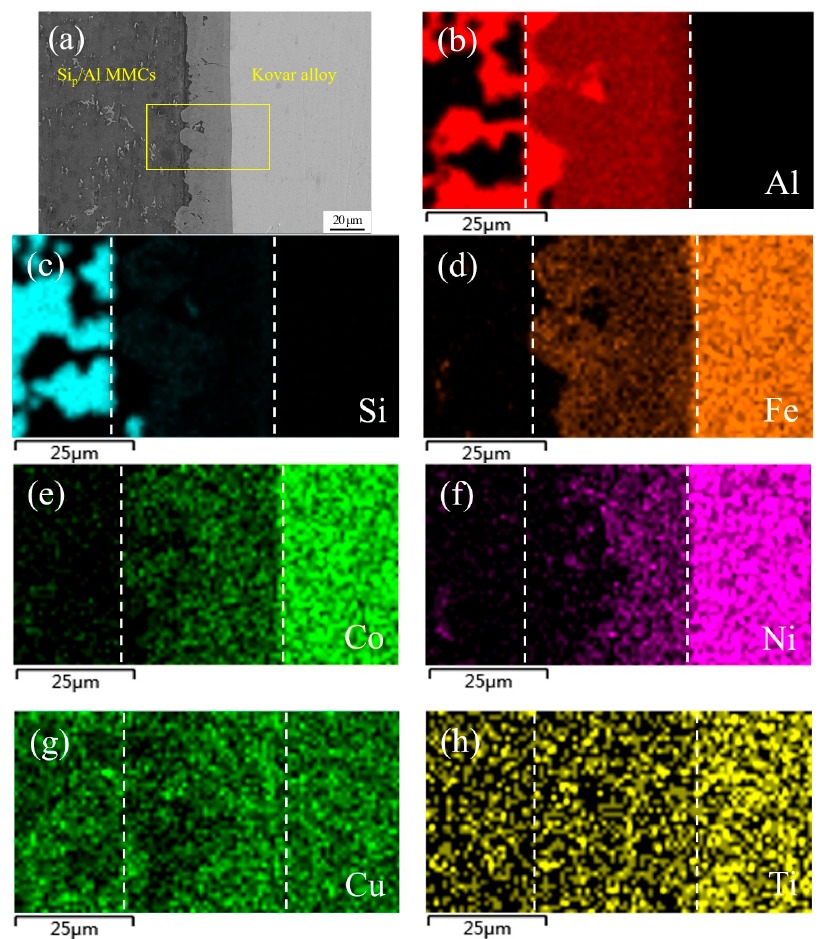
Figure 7. SEM image of typical region at the interface of 50 wt.% Si p /Al MMCs/Kovar made using Al- 7.5Si-23.0Cu-2.0Ni-1.0Ti at 580 °C for 30 min and corresponding energy dispersive X-ray maps showing distribution of elements: ( a ) SEM image; ( b – h ) individual elemental mapping of Al, Si, Fe, Co, Ni, Cu, and Ti, respectively.